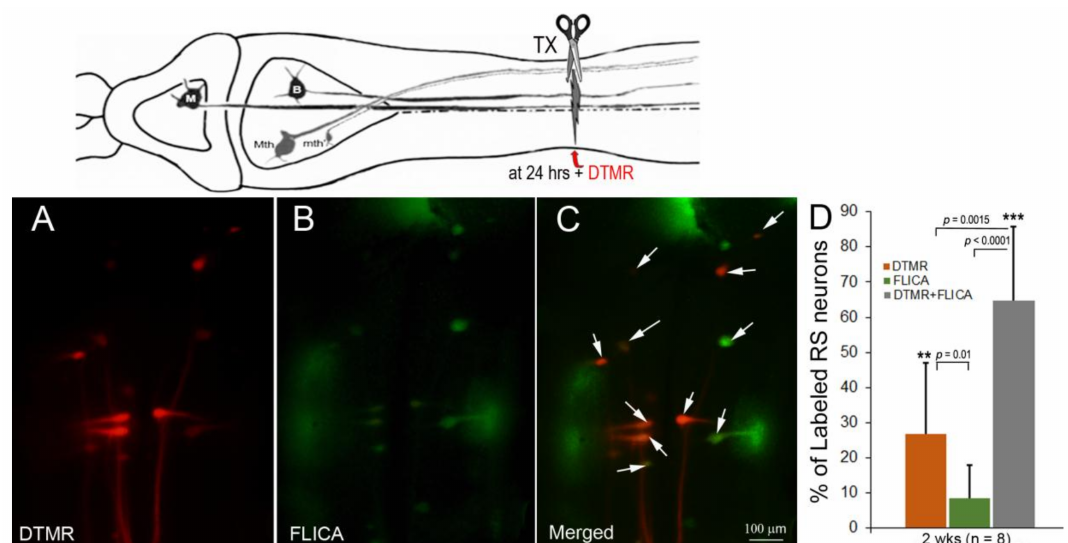
Figure 4. Association between delayed axon sealing and retrograde apoptosis signaling. Neurons with delayed axon sealing were retrogradely labeled with DTMR (red) applied to the spinal cord TX 24 h post-TX ( A ); after 2 weeks, the brains were processed for FLICA ( B ); the white arrows in the merged images ( C ) point to double-labeled neurons (many are faint); ( D ) counts of DTMR-labeled, Fluorescently-Labeled Inhibitor of Caspases (FLICA)-labeled, and double-labeled neurons. Most of the neurons were double-labeled. In the cartoon, M represents a mesencephalic Müller neuron; B represents a bulbar Müller